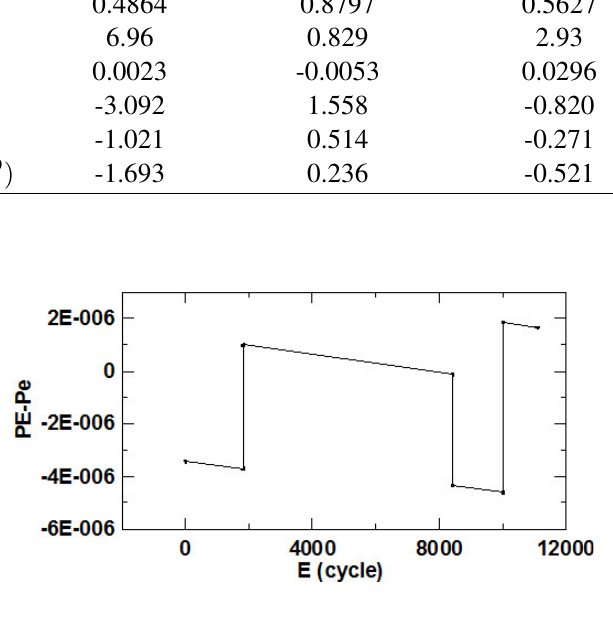
Fig. 9 Variations in the orbital period of IK Boo. Three jumps in the period are clearly